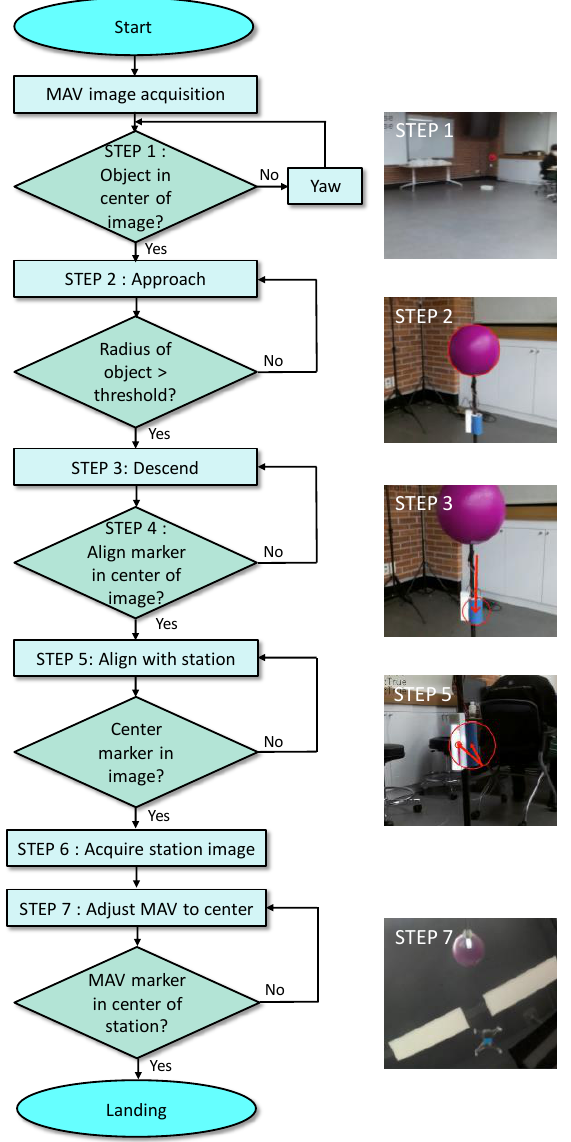
Figure 2. Proposed autonomous landing procedure. The MAV is controlled by seven velocity commands (forward, backward, left, right, up, down, and yaw) for maneuvering. Note that the MAV was controlled using the position data (in pixels) from the camera images. For example, when the MAV approaches the platform (STEP 2), the position of the spherical object (in pixels) in the image is selected as the reference position. A proportional-derivative (PD) control was used to allow a swift flight control of the MAV, as shown in Figure 3. Thus, the velocity command u ( t ) can be obtained as